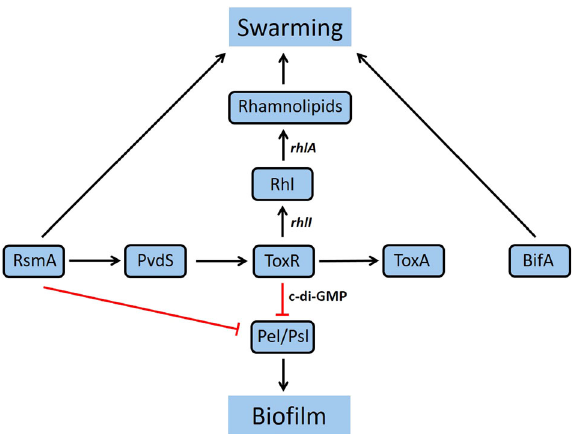
Fig. 8 Proposed regulatory pathway involving ToxR, RsmA and PvdS controlling P. aeruginosa swarming and bio fi lm formation. Elements acting positively or negatively are represented by arrow- heads and bars,